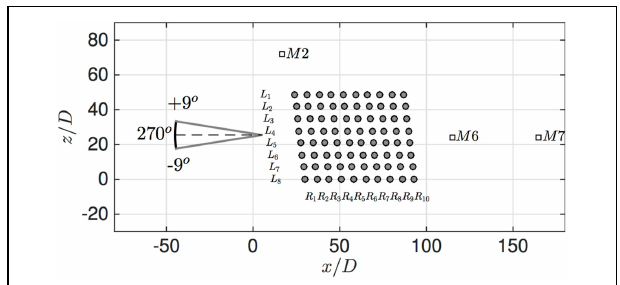
FIGURE 1 | Horns Rev: Rotor organisation and definition of the main wind